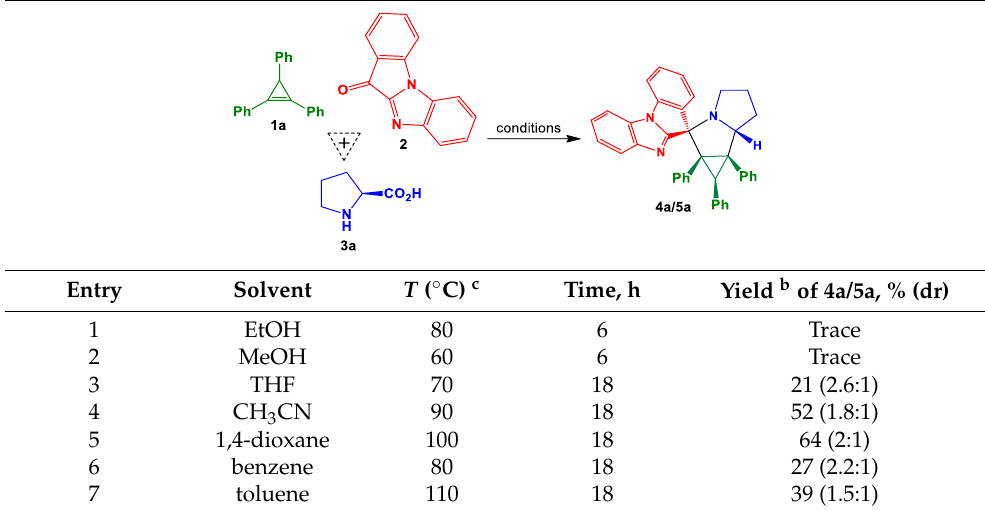
Table 1. Optimization of the Reaction Conditions a .